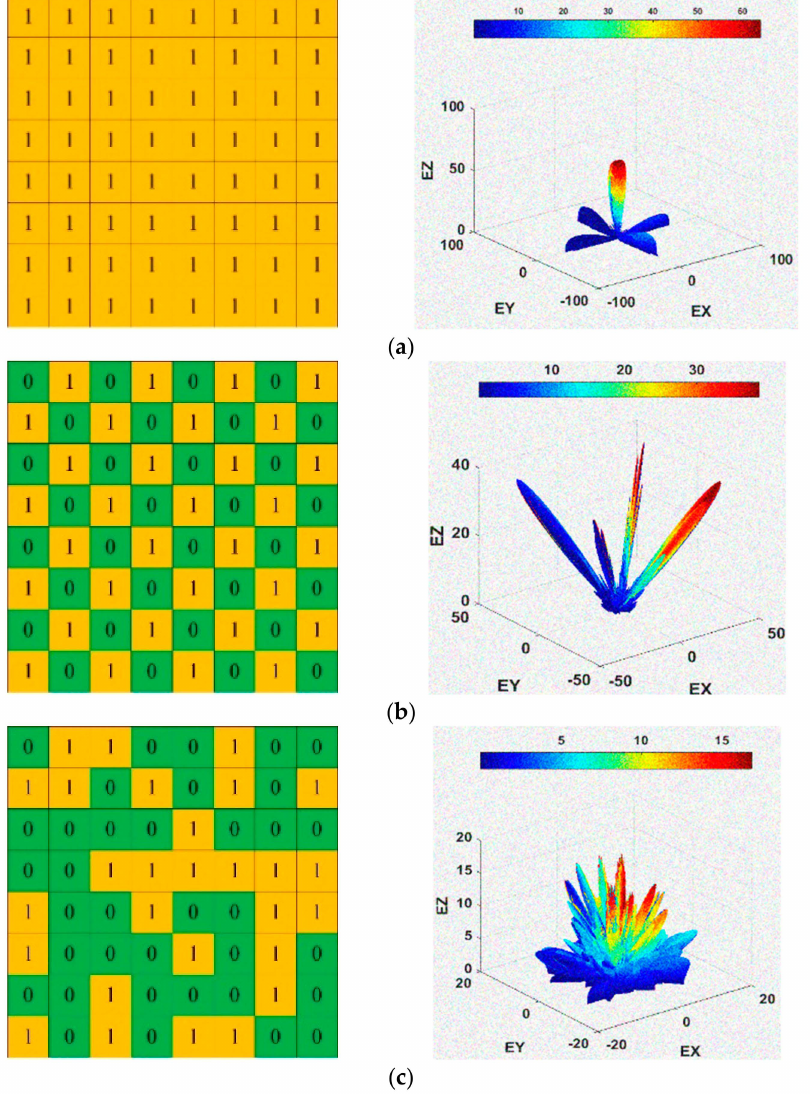
Figure 4. ( a ) Scattering field and two-dimensional code of metal; ( b ) Scattering field and two-dimensional code of chessboard metasurface; and, ( c ) Scattering field and two-dimensional code of coding di ff usion